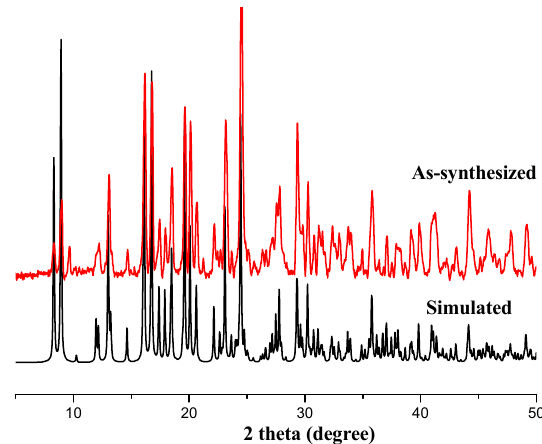
Figure 7. Simulated and experimental power X-ray diffraction (XRPD) pattern of complex 1 .